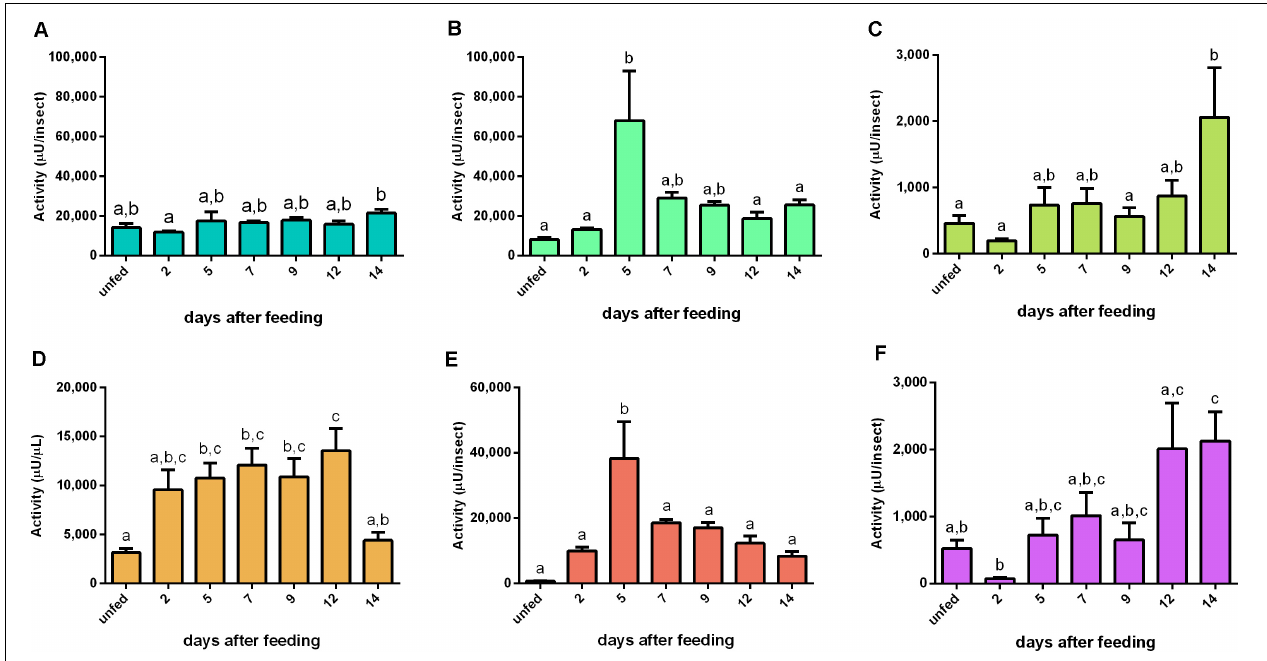
FIGURE 5 | Cathepsin D-like activity ( µ U per insect) in the different digestive compartment tissues and luminal contents of Rhodnius prolixus male adults, unfed and at 2, 5, 7, 9, 12, and 14 daf on defibrinated rabbit blood, assayed in 0.2 M glycine-HCl buffer, pH 3.6. (A) Anterior midgut tissues. (B) Posterior midgut tissues. (C) Hindgut tissues. (D) Anterior midgut contents. (E) Posterior midgut contents. (F) Hindgut contents. Figures are means ± SEM from nine different homogenate samples obtained from pools of two insects each. In a dataset, groups with the same superscript letter are not significantly different ( p > 0.05). Statistical analysis consisted of ordinary one-way ANOVA with Tukey’s multiple-comparisons test. Consider different scalings of